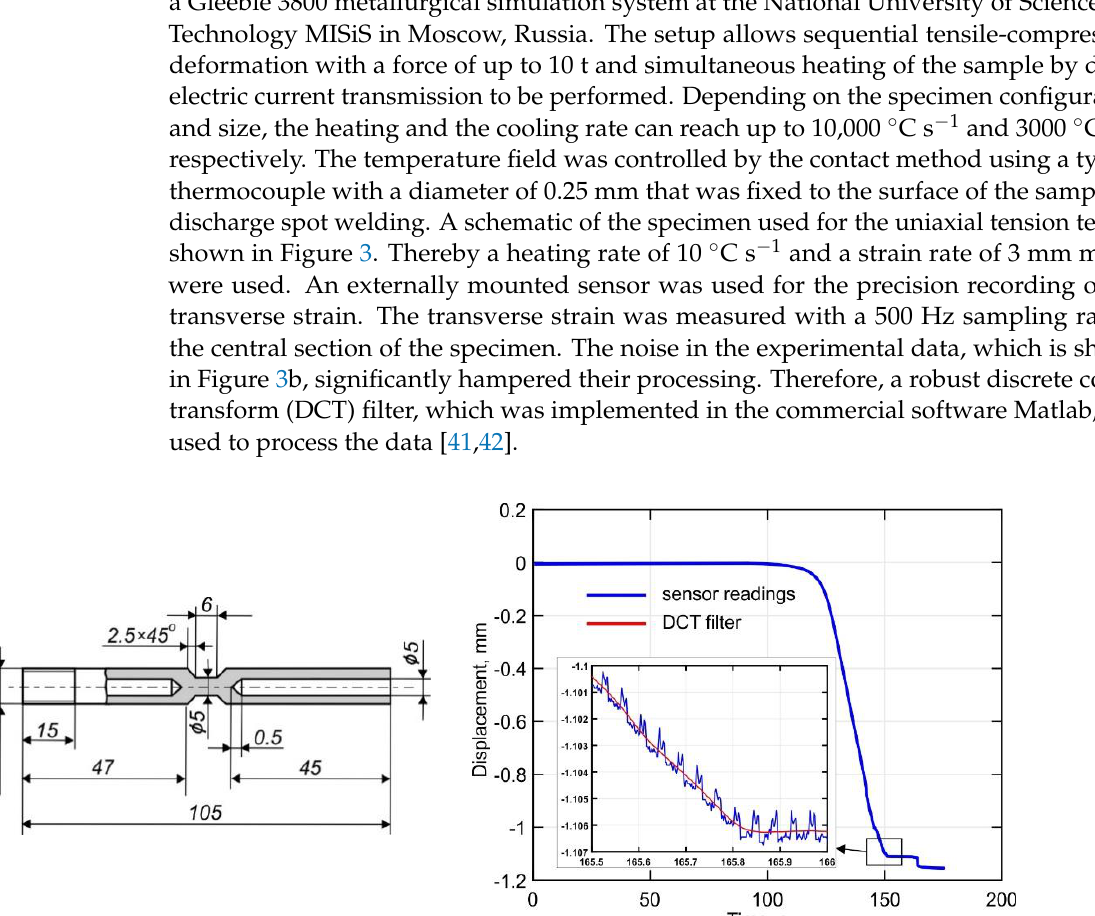
Figure 2. ( a ) Scanning electron micrograph of Ti-6Al-4V powder and ( b ) size distribution of the powder particles.